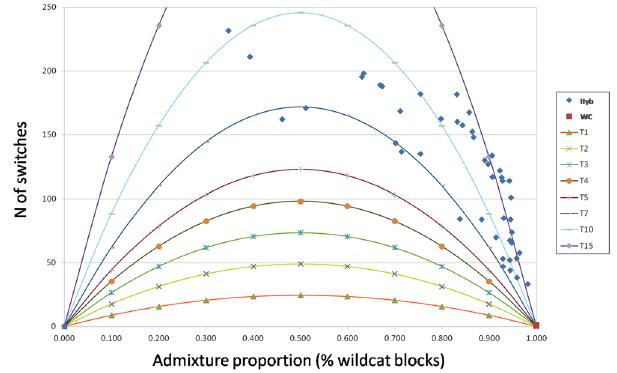
Figure 3. Timing since the admixture event for each admixed individual (Hyb = 45), deduced from the empirical distribution of the number of chromosomal switches inferred from PCAdmix, in relation to the individual assignment values (proportion of wildcat blocks). The colored lines indicate the expected distributions at increasing generations since